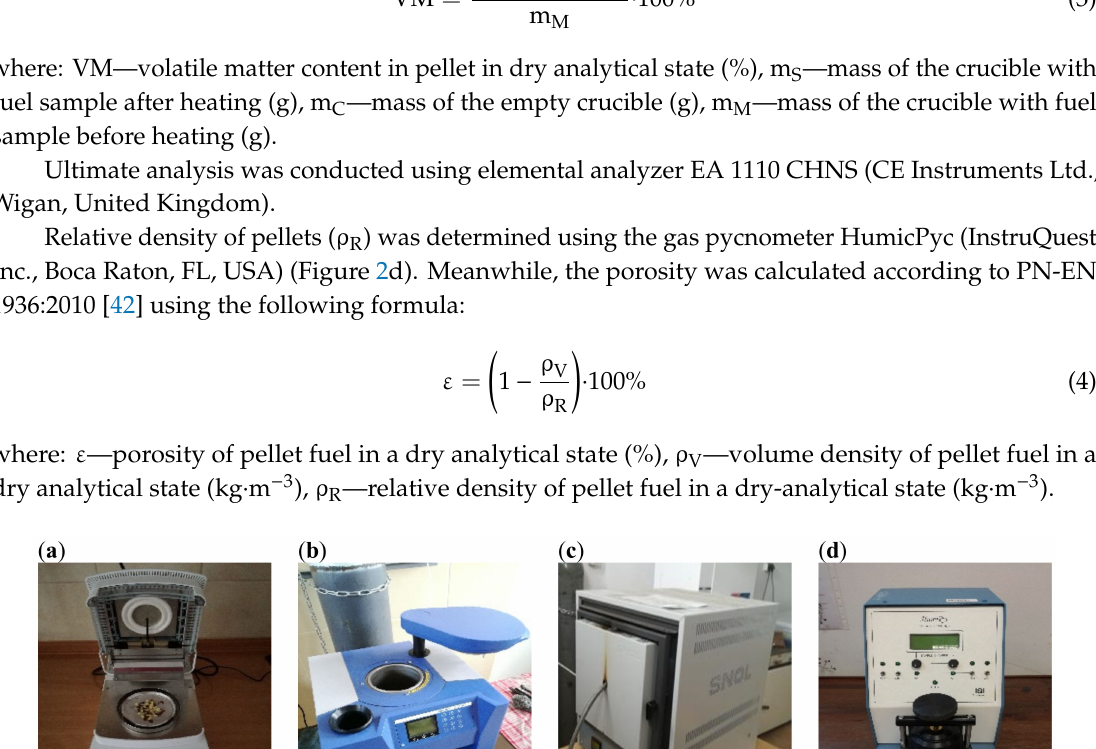
(Figure 2b) in accordance with PN-EN ISO 18125:2017-07 [38]. The lower heating value was determined using the following formula [39]: